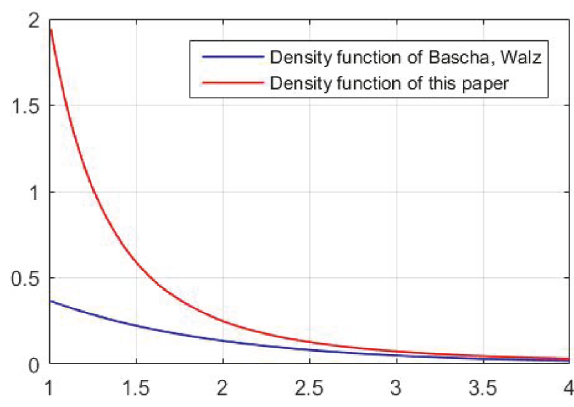
Figure 1: Comparison of two density